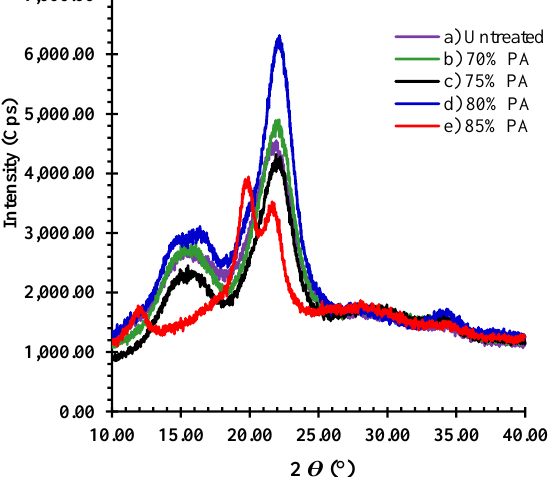
Figure 7. X-ray diffractogram pattern of treated and untreated core fibers.